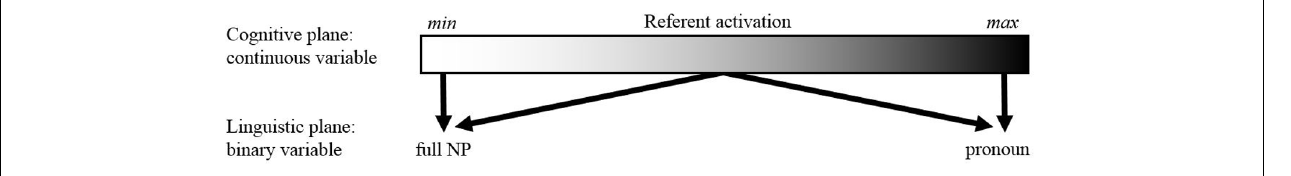
FIGURE 4 | Categorical and non-categorical referential